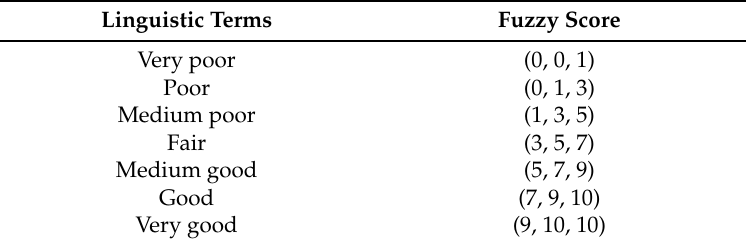
Table 1. Fuzzy evaluation scores for the